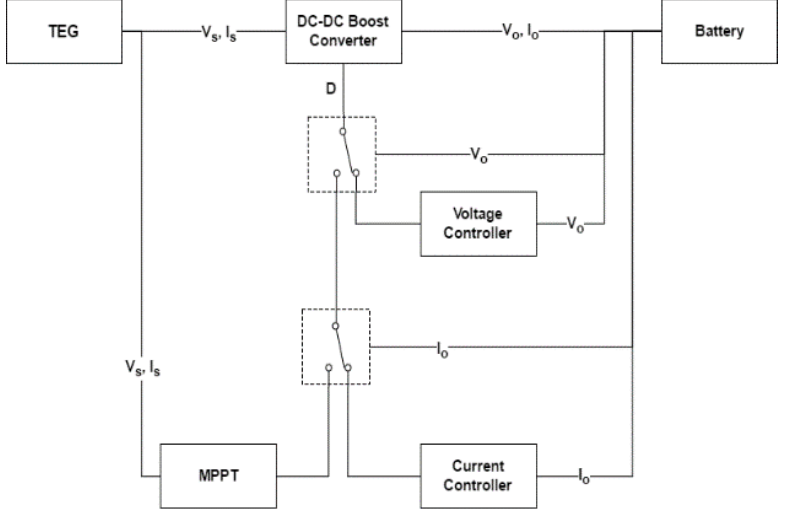
Figure 1. Proposed system block diagram